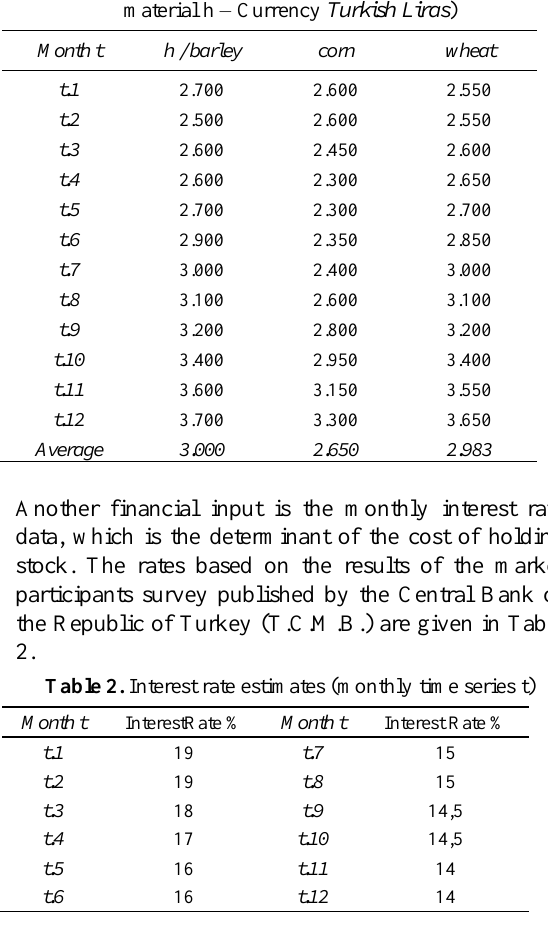
Table 1. Forecasted price data for grains (time series t, raw